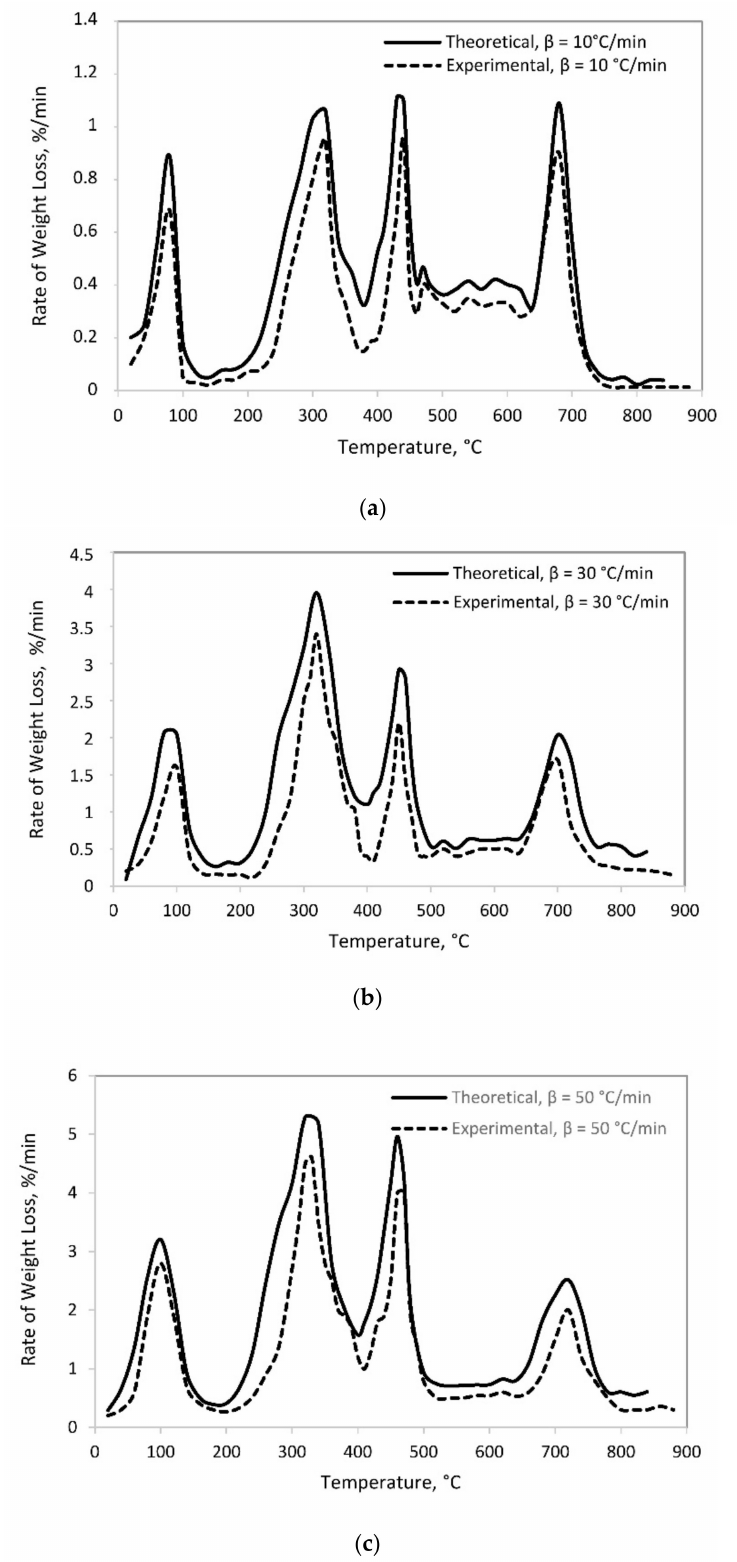
Figure 3. Comparison of theoretical and experimental data of SM/PET blend ( a ) β = 10 C ◦ /min, ( b ) β = 30 °C/min, ( c ) β = 50